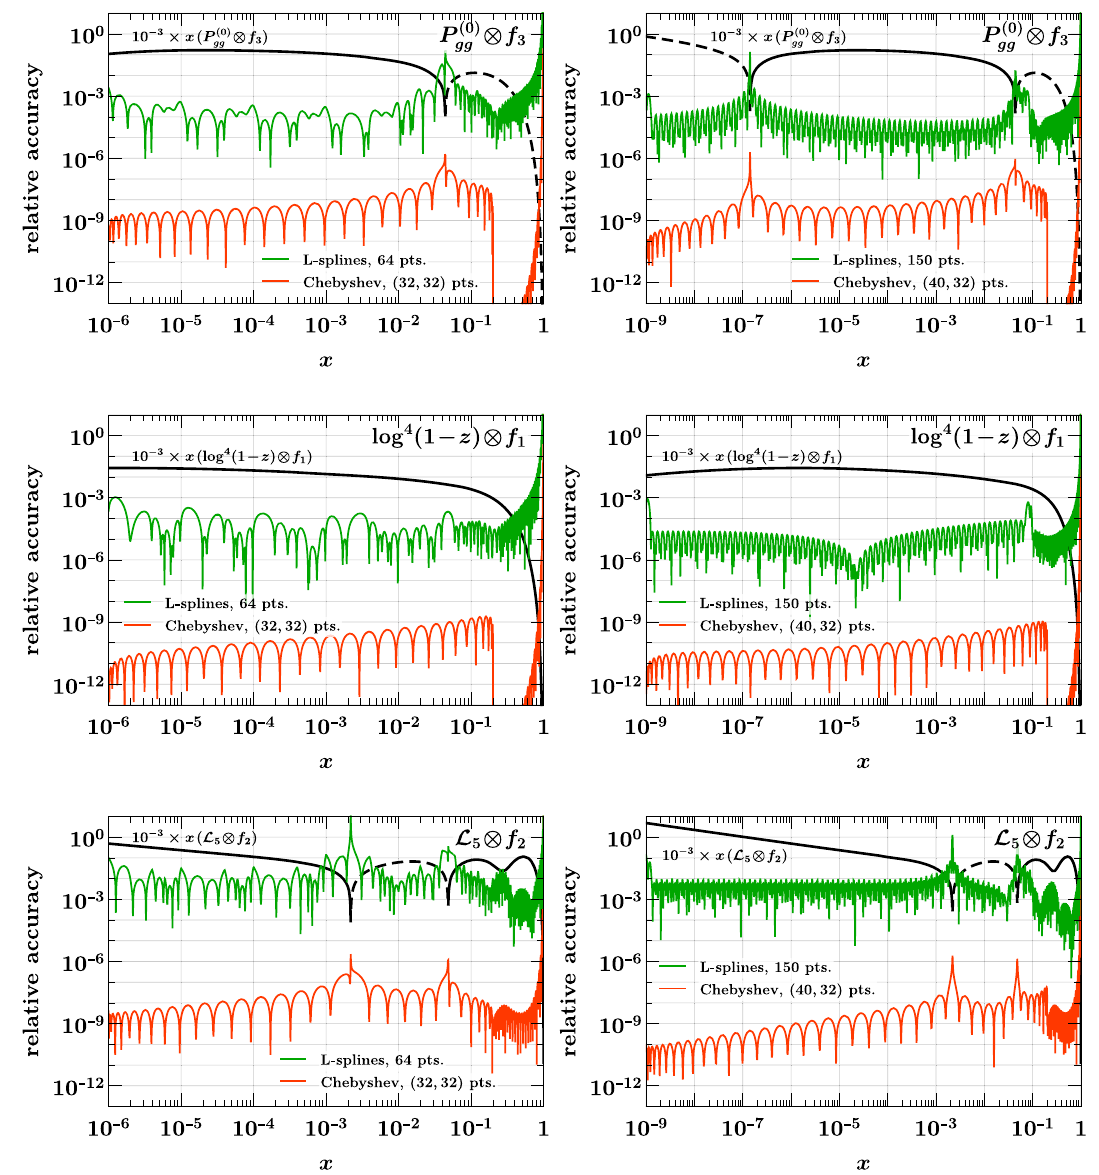
Fig. 10 Relative accuracy of Mellin convolutions. The red curves cor- respond to Chebyshev interpolation for both the PDF and the convolu- tion result, as described in the text. The green curves are obtained by performing the numerical convolution integral for the PDF interpolated with L-splines. Details about the convolution kernels are given in the